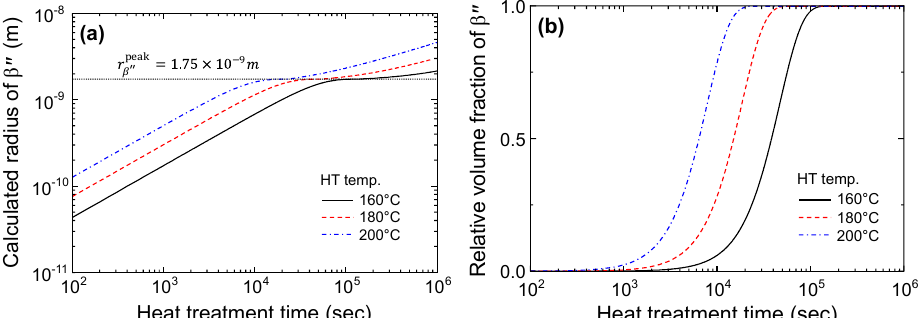
Figure 11. The calculated precipitation kinetics of β (cid:48)(cid:48) under various temperature conditions: ( a ) radius of β (cid:48)(cid:48) and ( b ) relative volume fraction of β (cid:48)(cid:48)